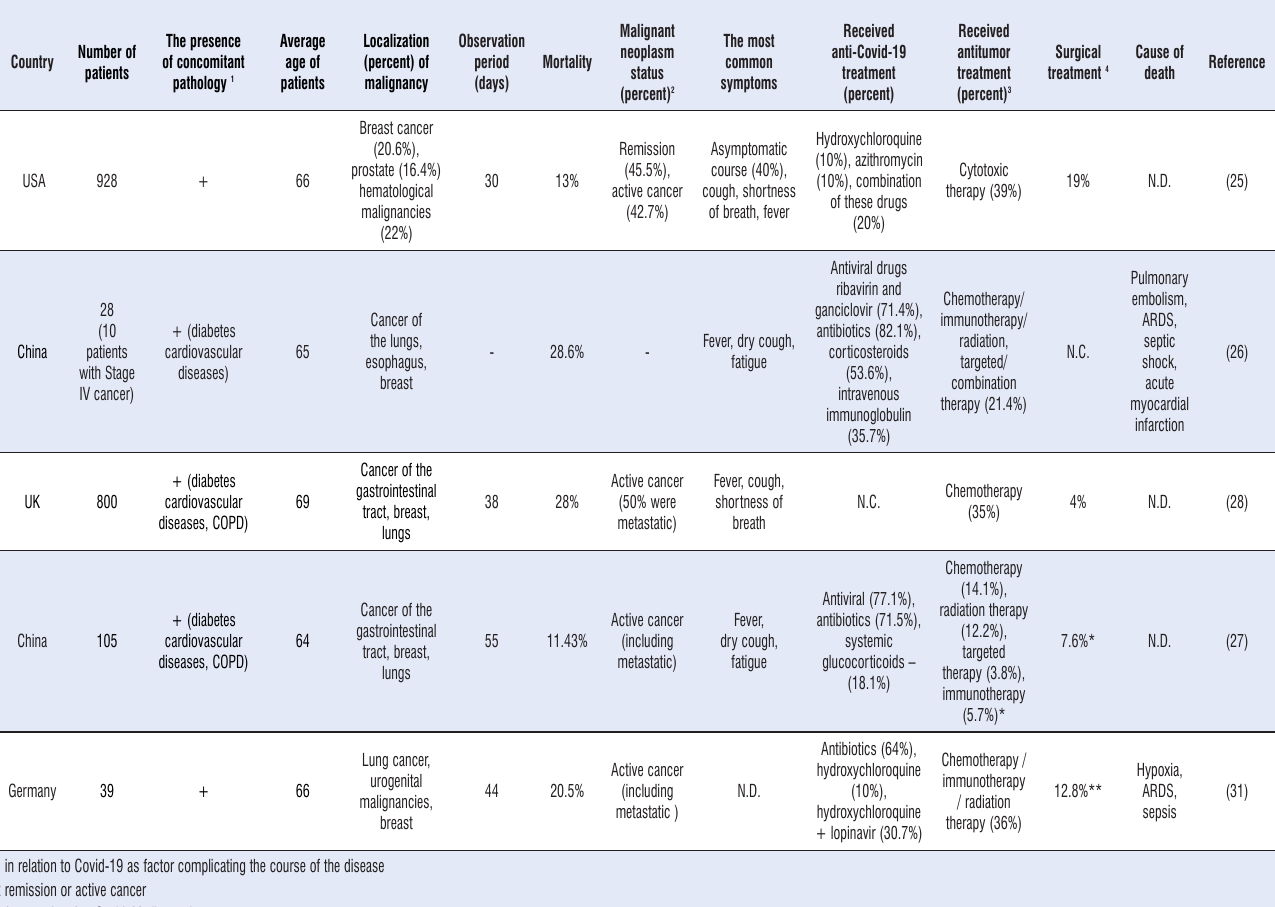
Table 1. Influence of antineoplastic therapy delay on